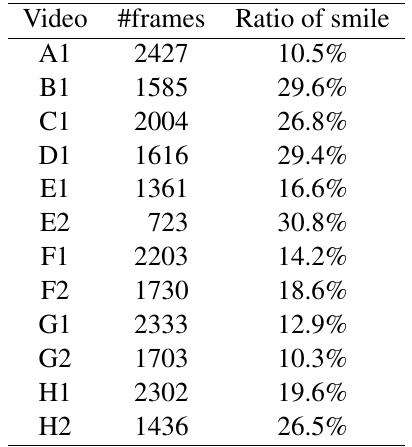
Table 1. Number of frames and ratio of smile in each video clip.